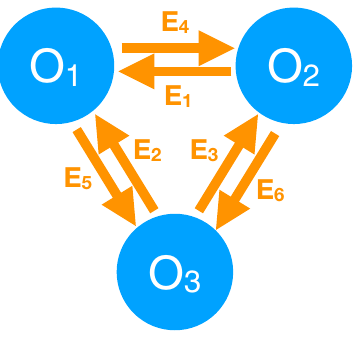
Fig. 6 An example graph with three fully connected vertices and the corresponding six edges